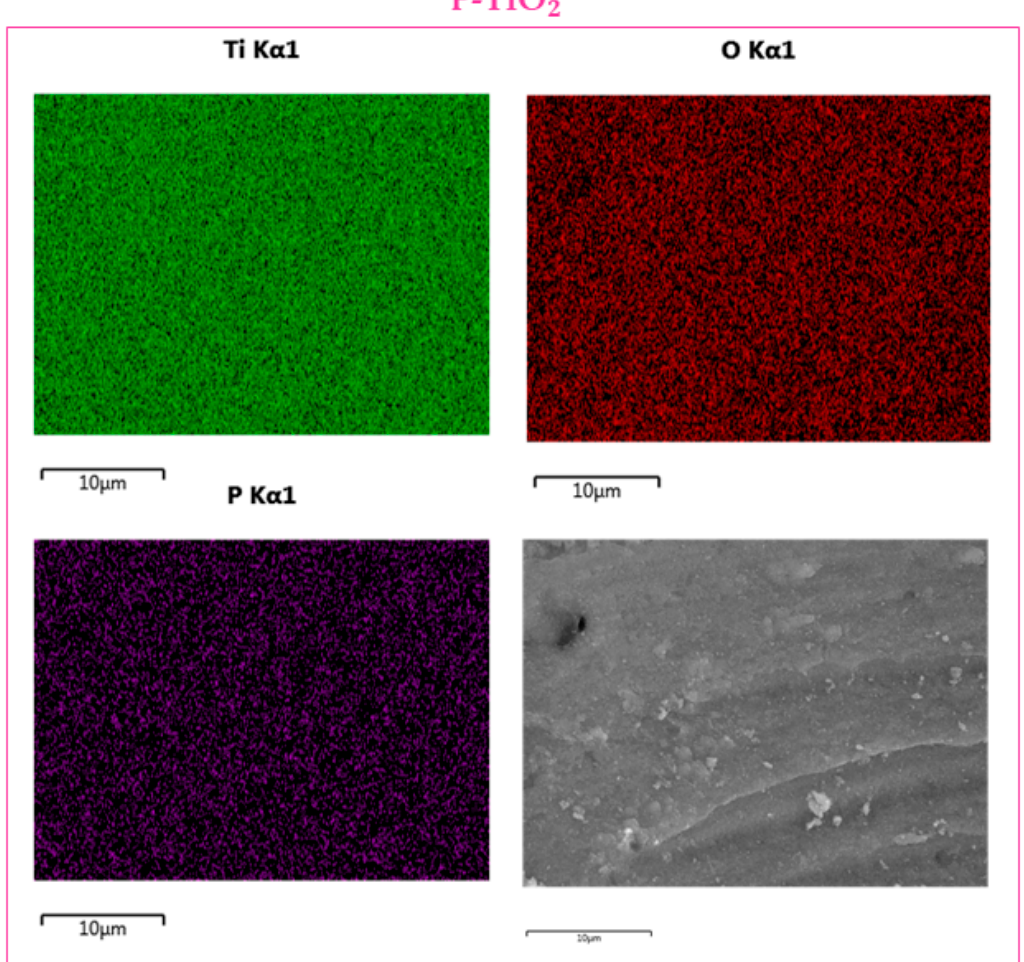
Figure 5. EDX maps over the P-doped sample.